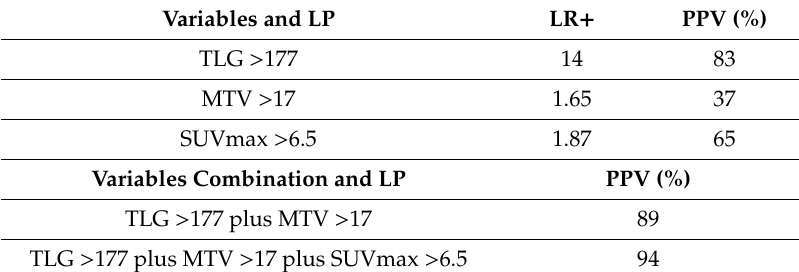
Table 4. Predictors of Local Progression (LP). The variables analyzed were the maximum standardized uptake value (SUVmax), the metabolic tumour volume (MTV), the total lesion glycolysis (TLG) of primary tumours. LR + , likelihood-ratio positive; PPV, Positive Predictive Value.